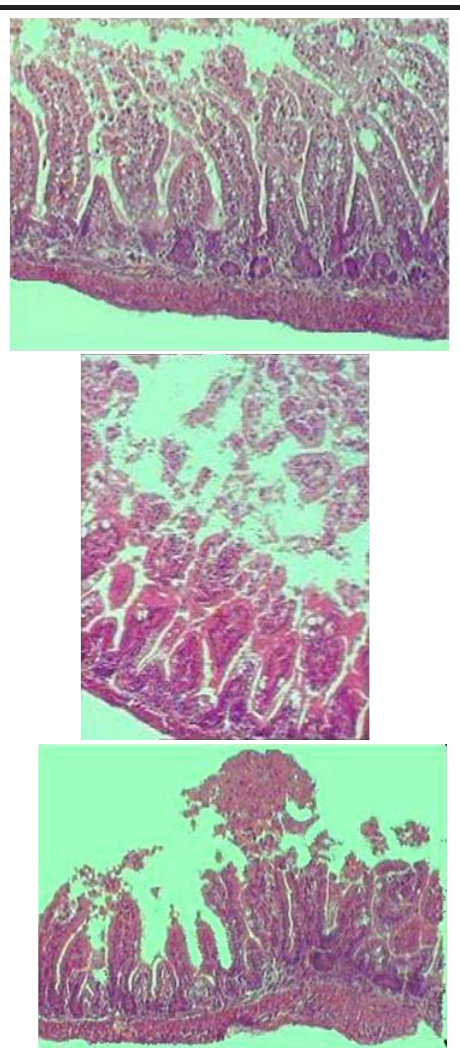
FIGURA 4 - Fotomicrografia de corte histológico de intestino do animal do Grupo H-R mostrando mucosa com destruição da porção livre das vilosidades, presença de capilares dilatados e de células inflamatórias (grau 3).